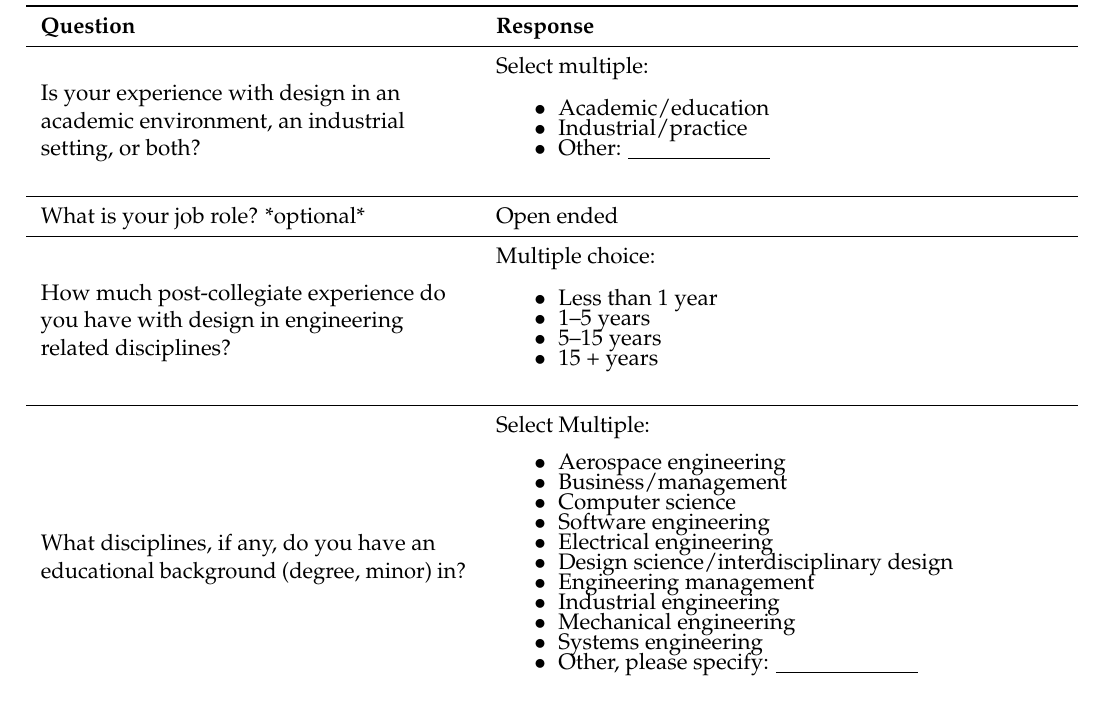
Table A1. Questions about design experience.